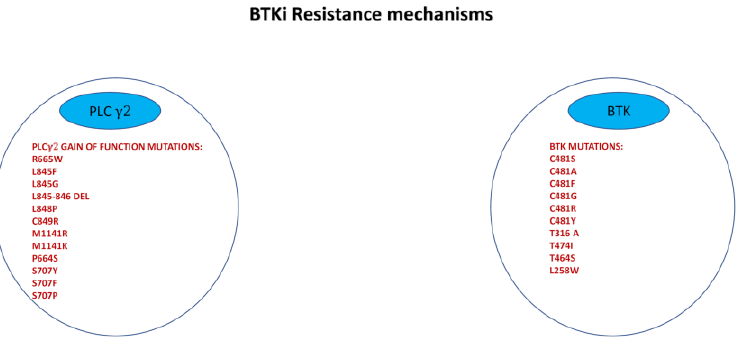
Figure 3. Spectrum of mutations related to BTKi resistance. The reversible BTKi (pirtobrutinib, vecabrutinib, ARQ531, fenebrutinib),